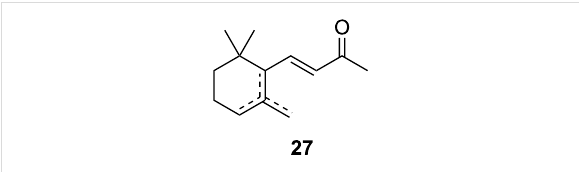
Figure 3: Main constituents of natural iris oil: irone ( 27 ).